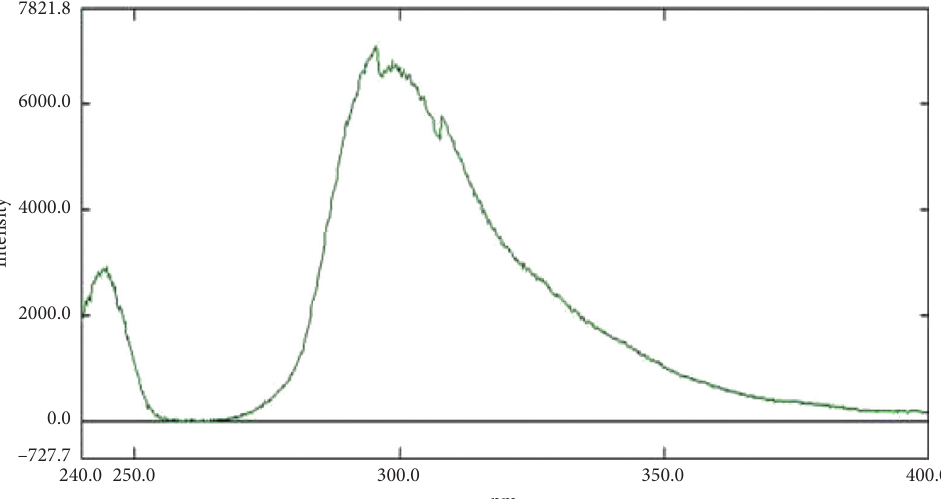
Figure 5: Emission spectra of a biological sample at 299.4nm after excitation at 226.5nm after 1 hour (estimated Cmax based on literature [14]) after oral administration of empagliflozin with a concentration of